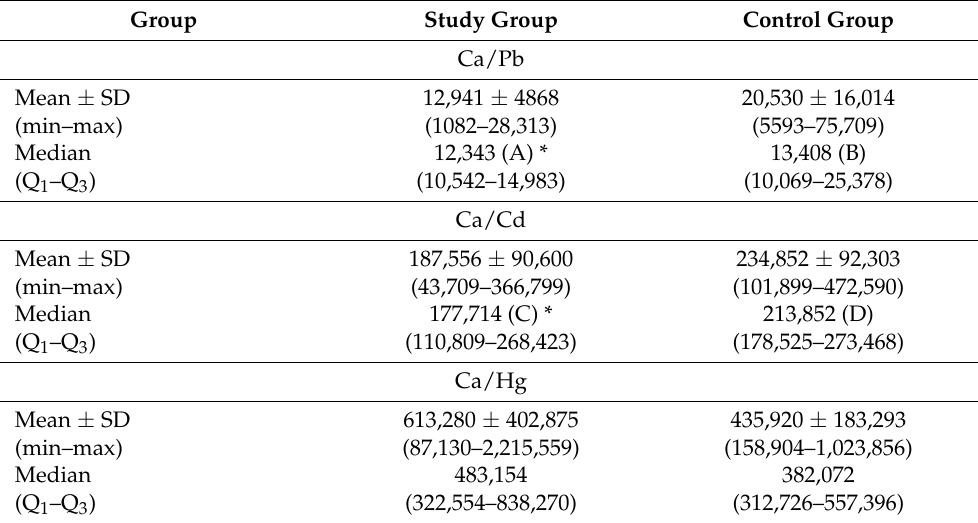
Table 4. Molar ratios of Ca to Pb, Cd and Hg concentrations in patients with osteoarthritis of the spine and healthy people.